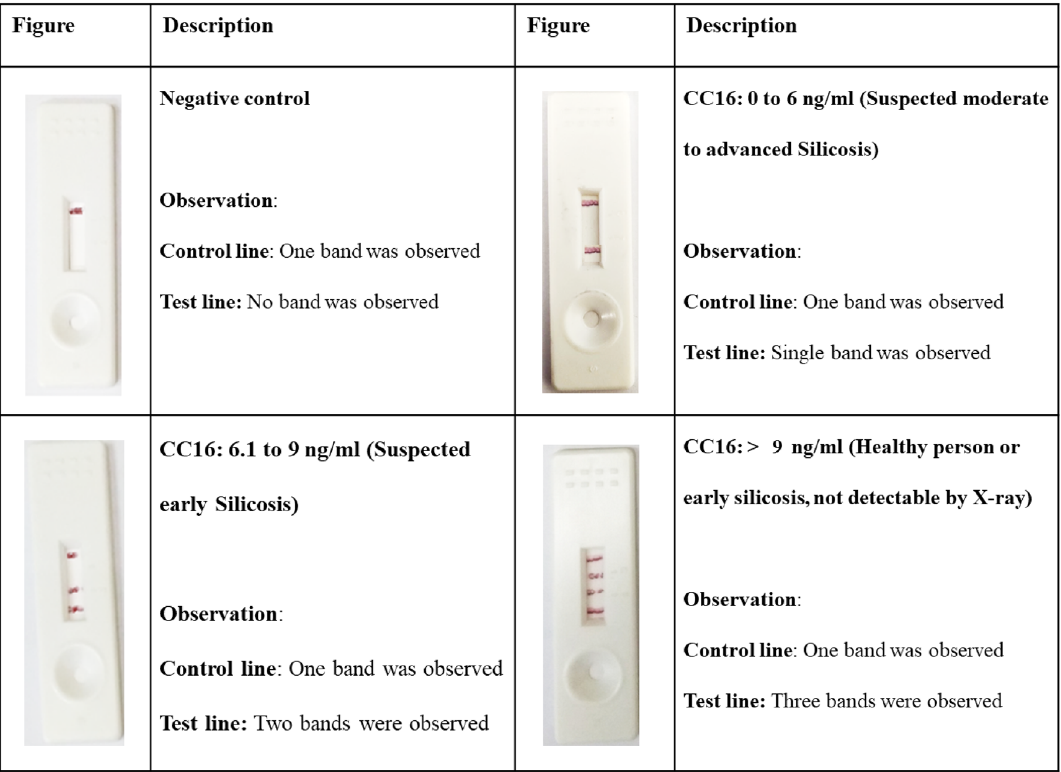
Figure 1. Detailed description for interpretation of results for semi-quantitative lateral flow assay for detection of CC16.